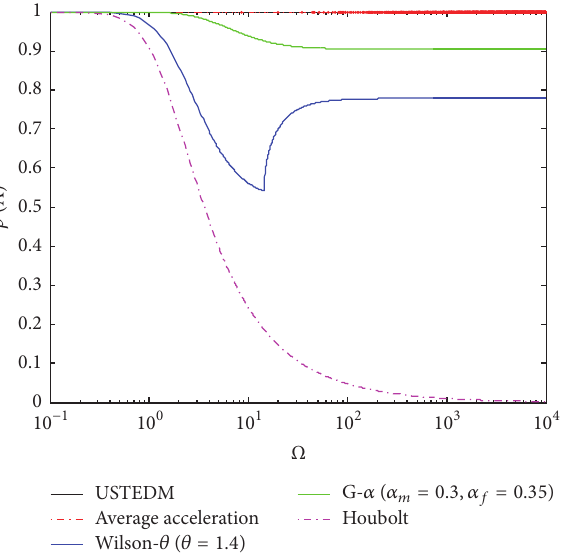
Figure 4: Comparison of relative period